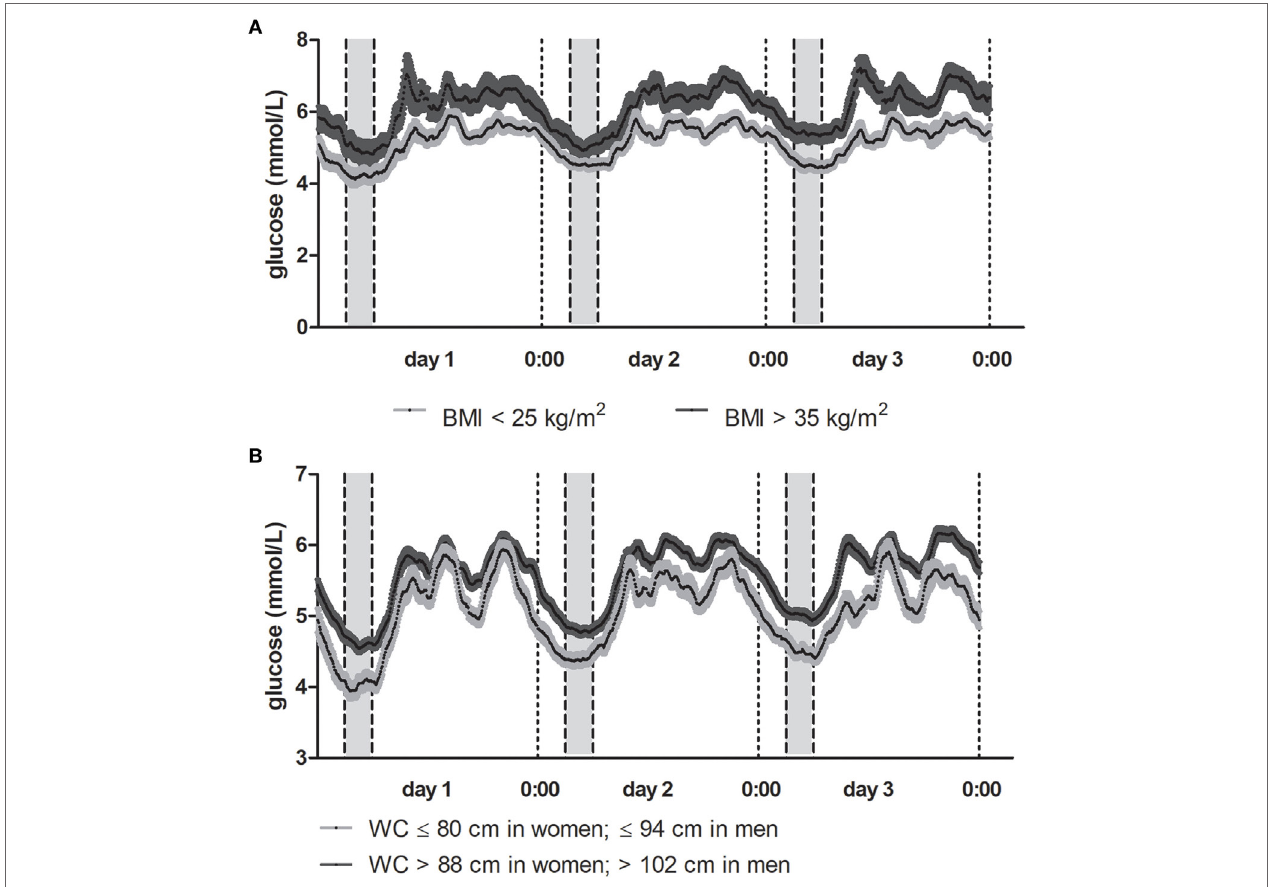
FigUre 1 | (a) Mean glucose trajectory in participants by body mass index (BMI). Results depicted as the mean (SE) glucose concentrations per 5-min interval for a 72-h period. In dark gray, mean (SE) glucose trajectory for participants with BMI > 35 kg/m 2 . In light gray, mean (SE) glucose trajectory for participants with BMI < 25 kg/m 2 . (B) Mean glucose trajectory in participants by waist circumference. Results depicted as the mean (SE) glucose concentrations per 5-min interval for a 72-h period. In dark gray, mean (SE) glucose trajectory for participants with the longest waist circumference ( > 88 cm in women, > 102 cm in men). In light gray, mean (SE) glucose trajectory for participants with the shortest waist circumference ( ≤ 80 cm in women, ≤ 94 cm in men).